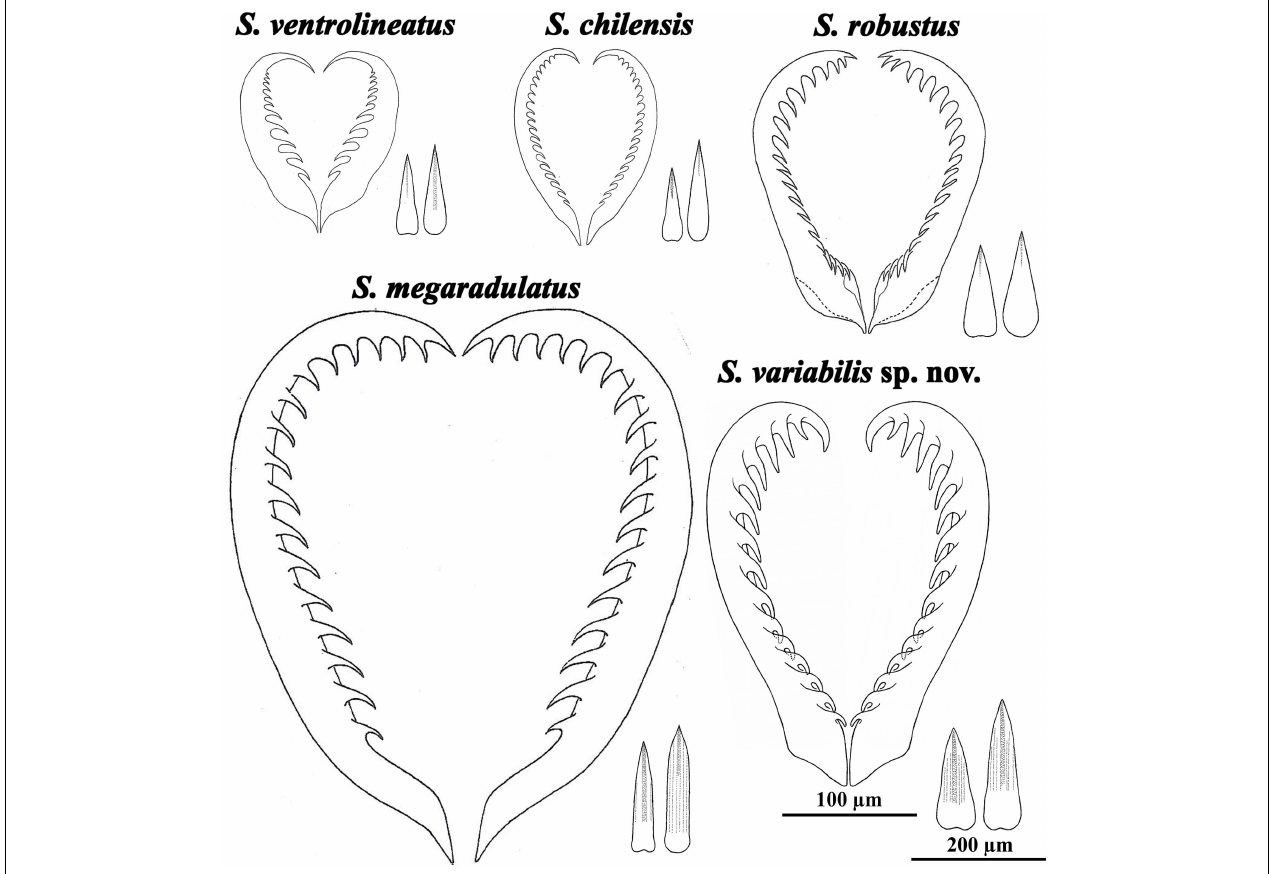
FIGURE 9 | Radula (in same scale) and trunk sclerites (idem) of Scutopus species, obtained from different sources: Salvini-Plawen (1970): figs. 1 (radula) and 3(i, l) (sclerites) of S. ventrolineatus , figs. 2 (radula) and 4(e, g) (sclerites) of S. robustus ; Salvini-Plawen (1972): figs. 22 (radula) and 24(g, h) of S. megaradulatus , figs. 27 (radula) and 23(m, p) (sclerites) of S. chilensis . The radula of S. variabilis sp. nov. was drawn based on the Figure 4 ; its sclerites were based on the first illustrated in row (E) and the last of row (G) of Figure 3 . The radula and sclerites of the Pacific S. schanderi and S. hamatanii were illustrated by Saito and Salvini-Plawen